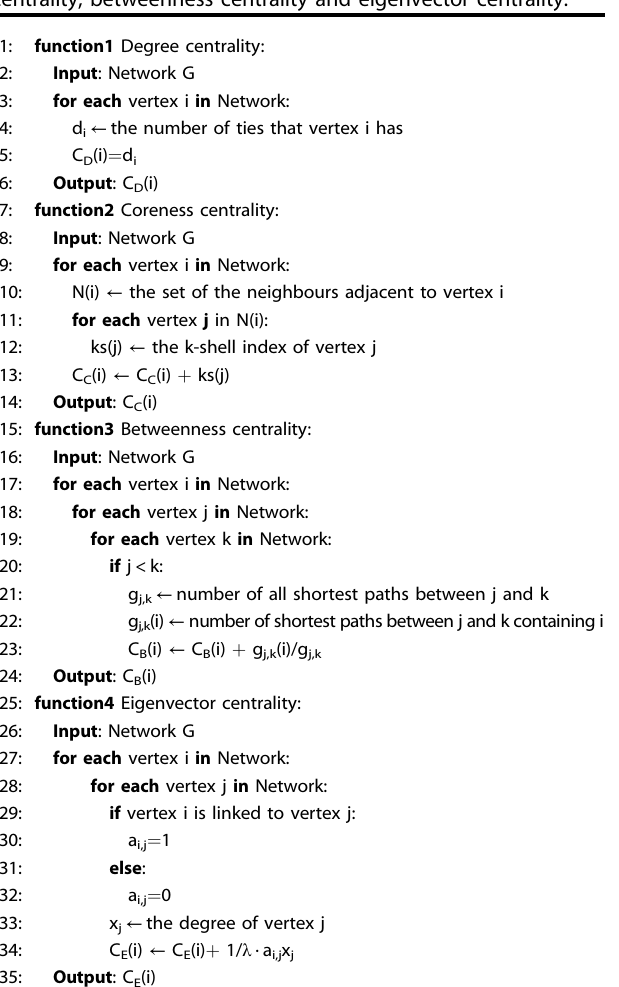
Algorithm 3 . The algorithm of degree centrality, coreness centrality, betweenness centrality and eigenvector